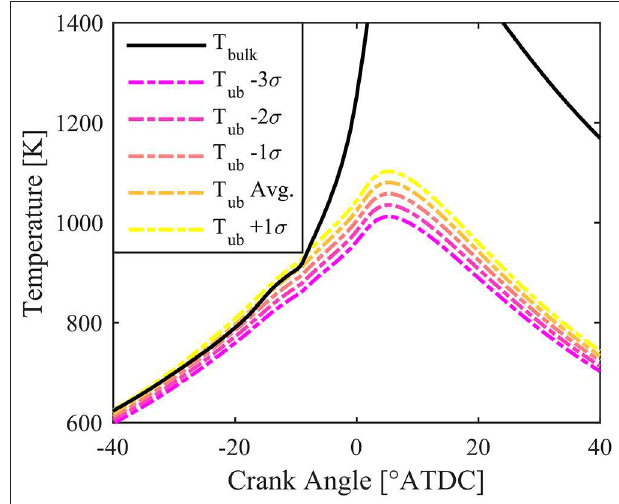
FIGURE 1 | Unburned temperature profiles for various multiples of the standard deviation of temperature as a function of crank angle compared to the bulk gas temperature for an example